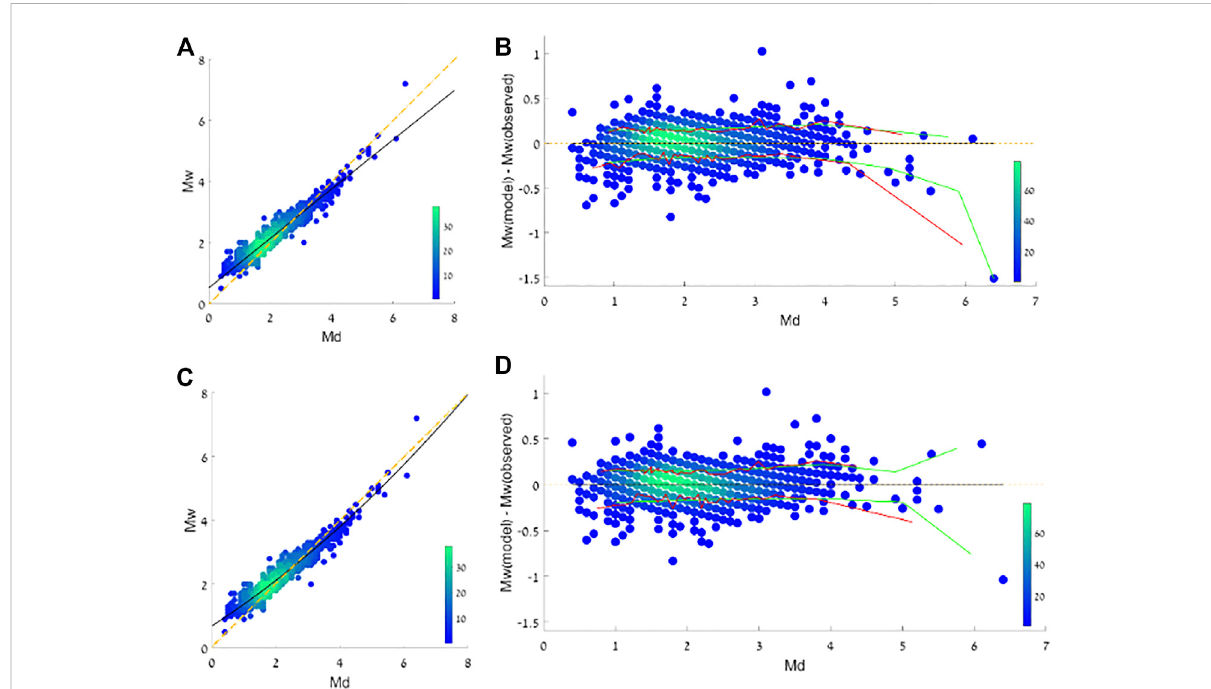
FIGURE 3 Linear and Quadratic fi ts of the current study, within the RA. Black lines in (A,C) are linear and quadratic fi ts, respectively, within RA, superimposedontheassociatedearthquakedata.Dashedyellowlinesrepresent1:1ratio.Residualsfromthese fi tsarescatteredforthelinear (B) and quadratic (D) fi ts;wheretheblacklineisthelinear fi toftheseresiduals,dashedyellowlinerepresents1:1ratio;GreenandRedlinesshowthedetailed RMSEinintervalsof25eventsinanascendingorderofmagnitudes,andinintervalsofasinglemagnitude,respectively,calculatedseparatelyfor the negative and positive